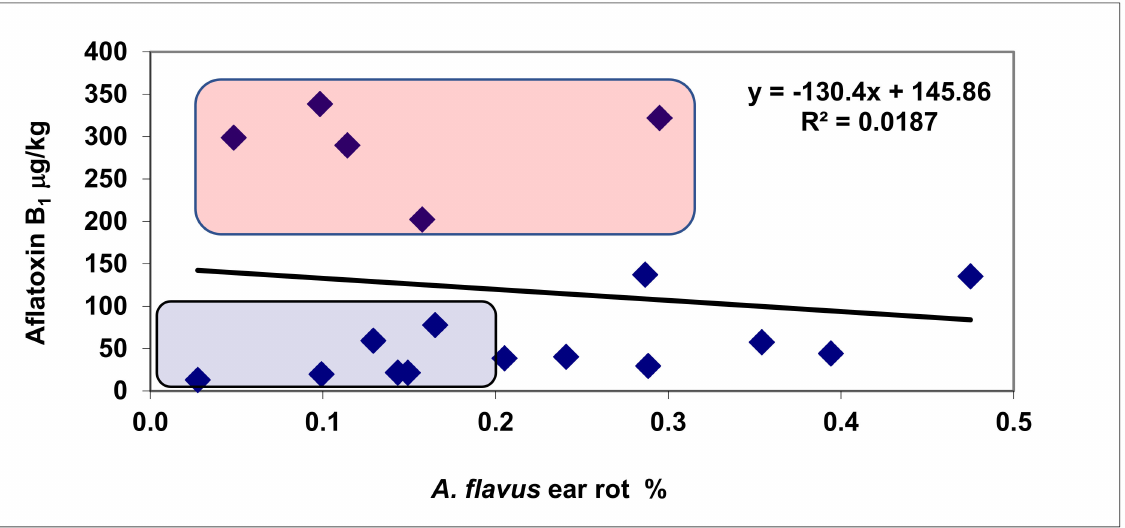
Figure 3. A. flavus ear rot and aflatoxin B 1 in 2017–2018. The LSD 5% value for aflatoxin B1 is 66.29. Five hybrids show differences between data points and their corresponding points on the line higher than the LSD 5% value of 66.29 (between 76.9 and 214.6 mg/kg); they are considered toxin overproducers (rose color). Variances for the toxins can be found for each data point in Table S2.